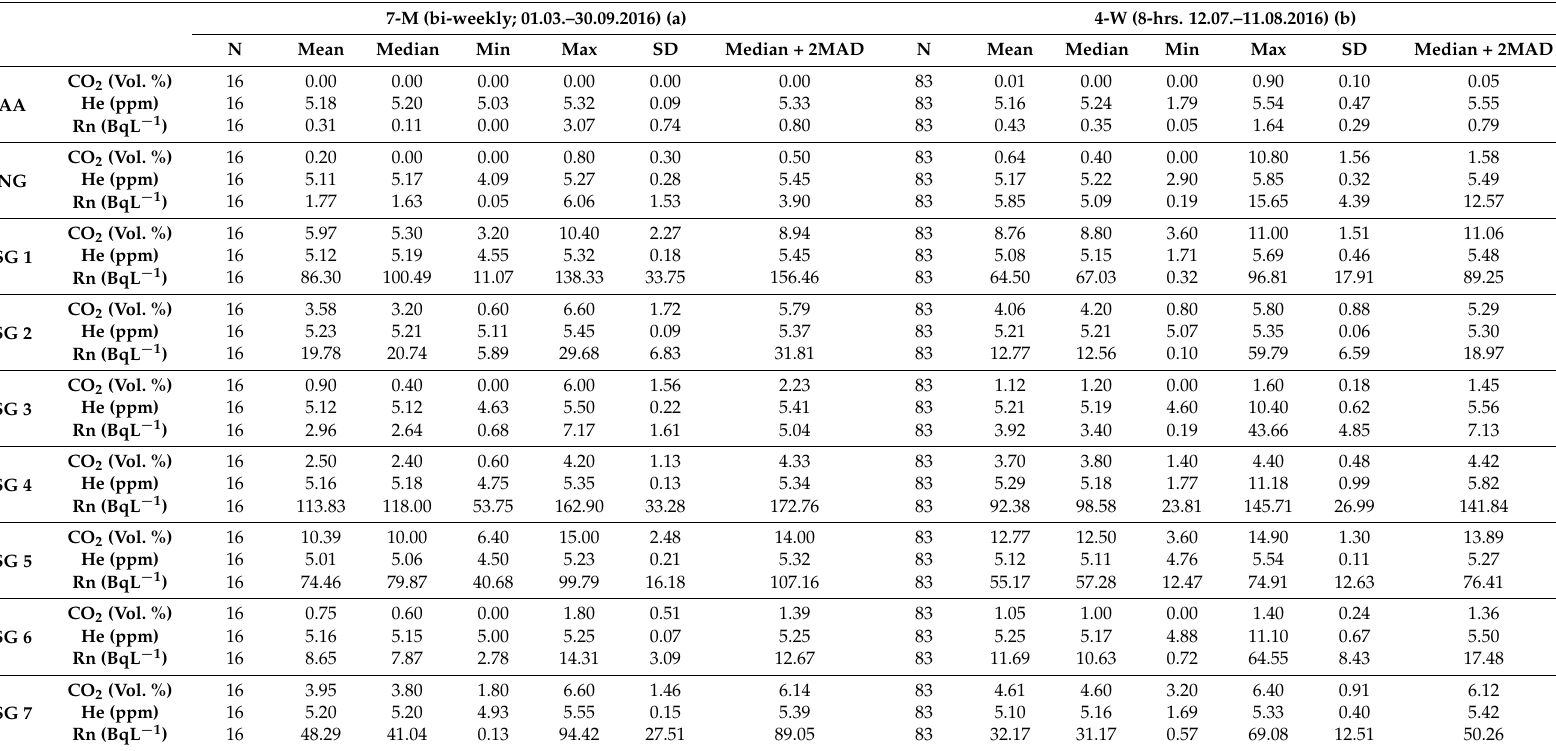
Table 1. Gas concentrations in ambient air (AA), NG, and SG for (a) 7-M and (b) 4-W